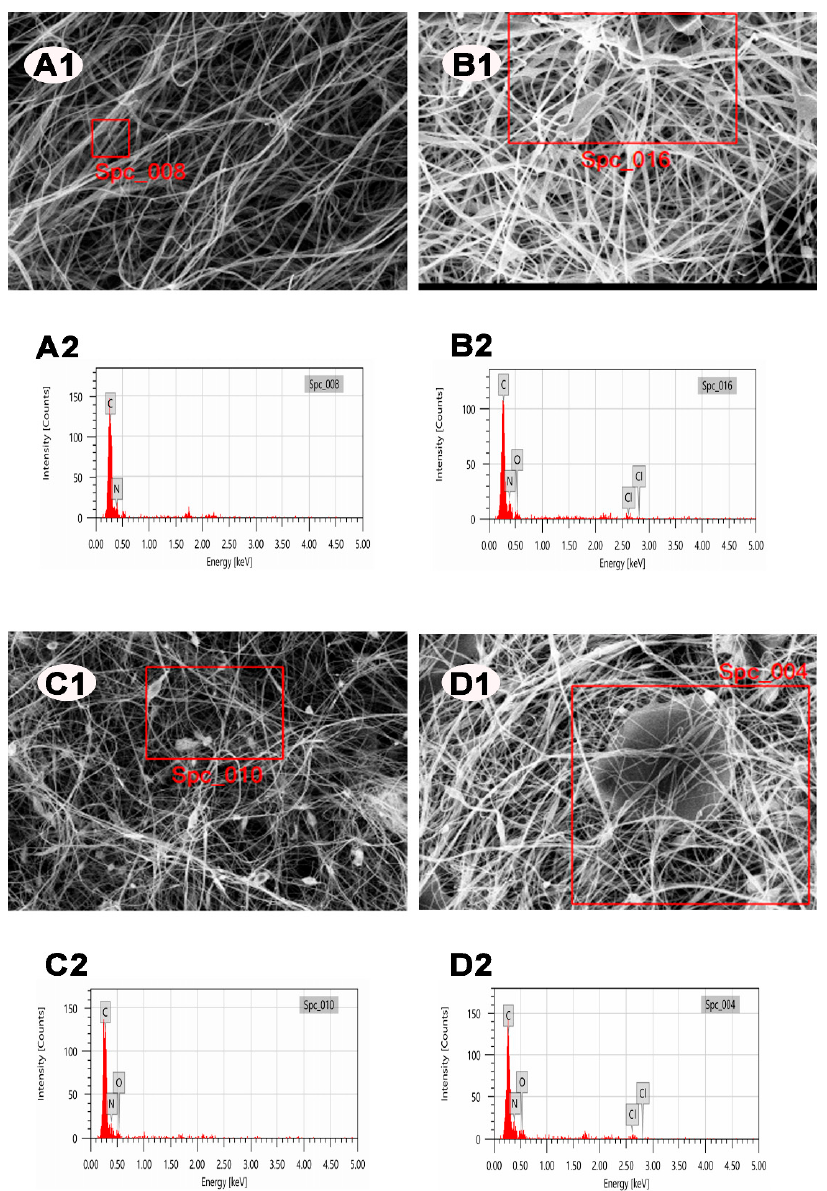
Figure 4. ( A1 , B1 , C1 , D1 ) SEM images and ( A2 , B2 , C2 , D2 ) EDX spectra of ( A ) PAN, ( B ) PAN/DCDMH, ( C ) PAN/GO, and ( D )